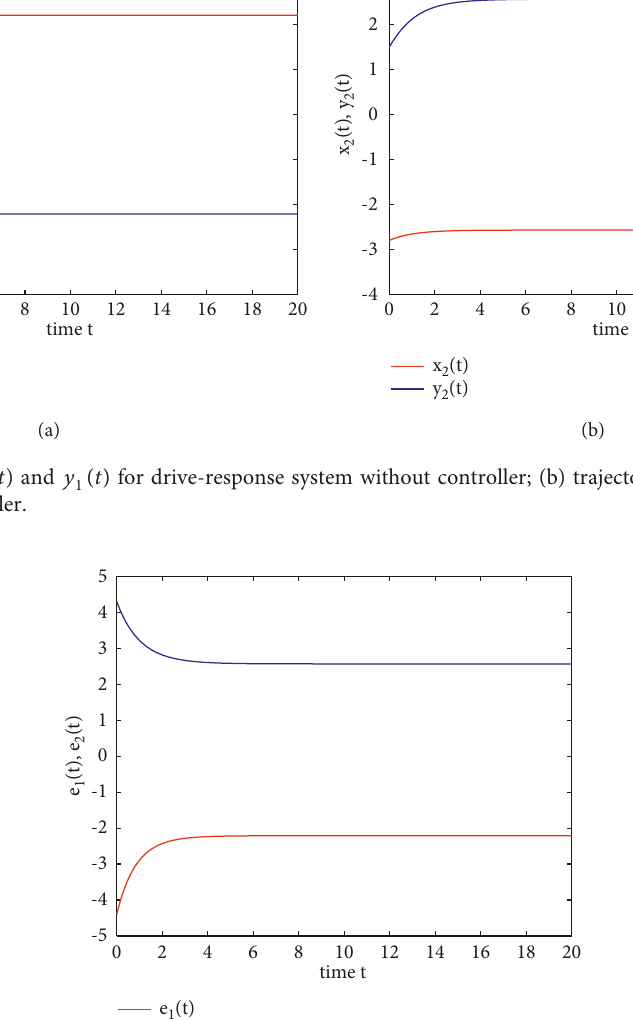
Figure 10: Trajectories of e